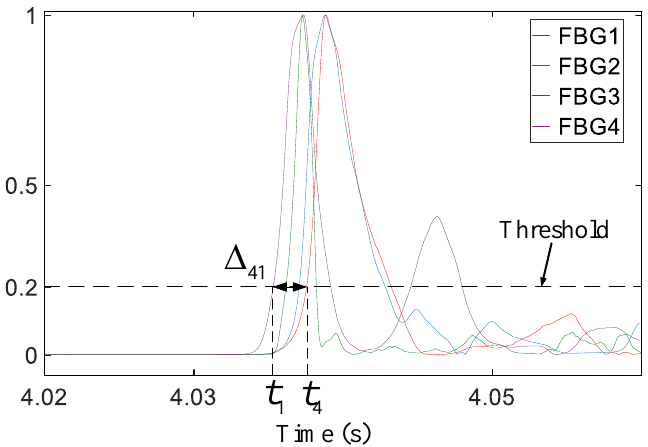
Figure 9. Time difference of the instant Teager energy. Sensors 2021 , 21 , x. https://doi.org/10.3390/xxxxx